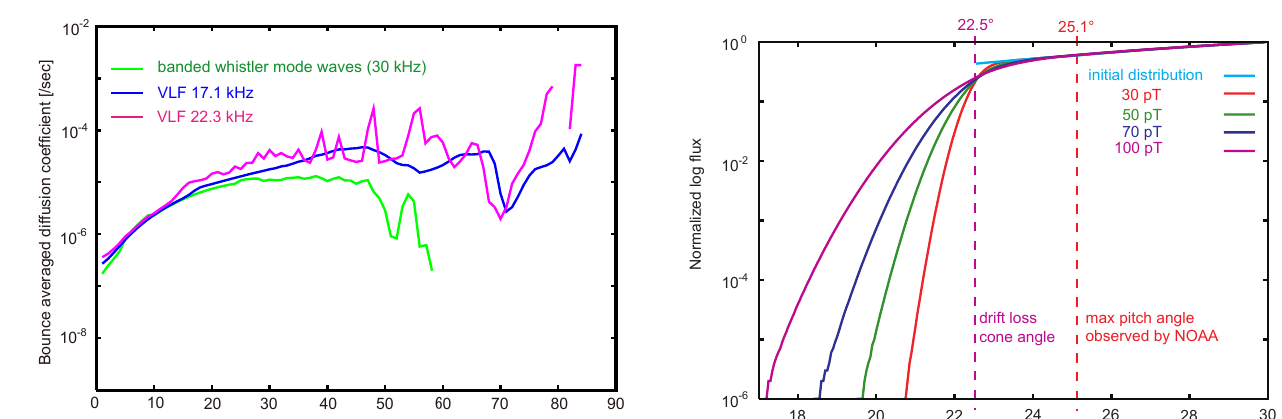
[deg]18 Equatorial pitch angle Figure 10 Tadokoro et al.,2009 Fig. 10. Pitch angle distributions after one drift period for various wave magnetic field amplitudes, 30, 50, 70, and 100pT at L =2.0. The initial distribution is adopted from the electron flux at 341keV observed by the CRRES satellite. The dashed red and purple lines indicate the maximum equatorial pitch angle observed by NOAA and the drift loss cone angle,